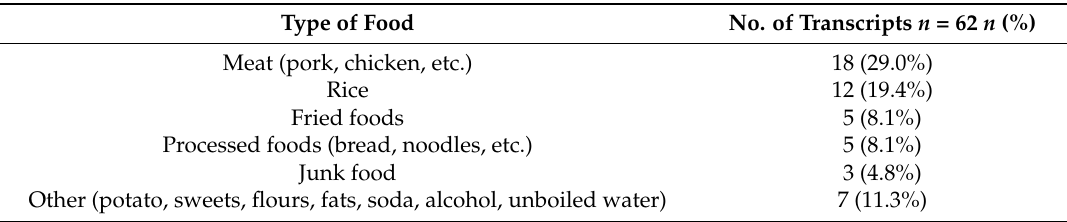
Table 2. “Mala alimentaci ó n”. Type of